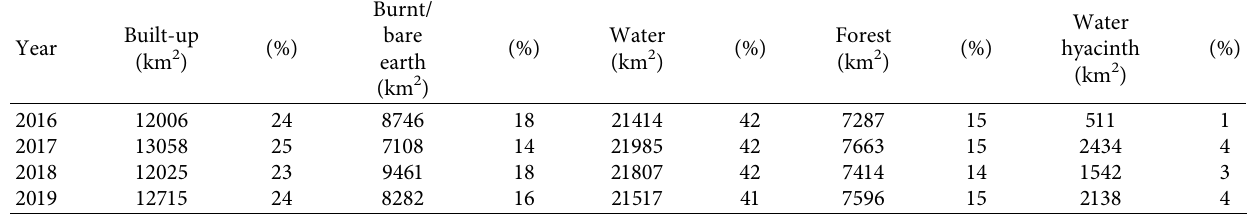
Table 2: Areal extent statistics of land cover around the Murchison Bay between 2016 and 2019.